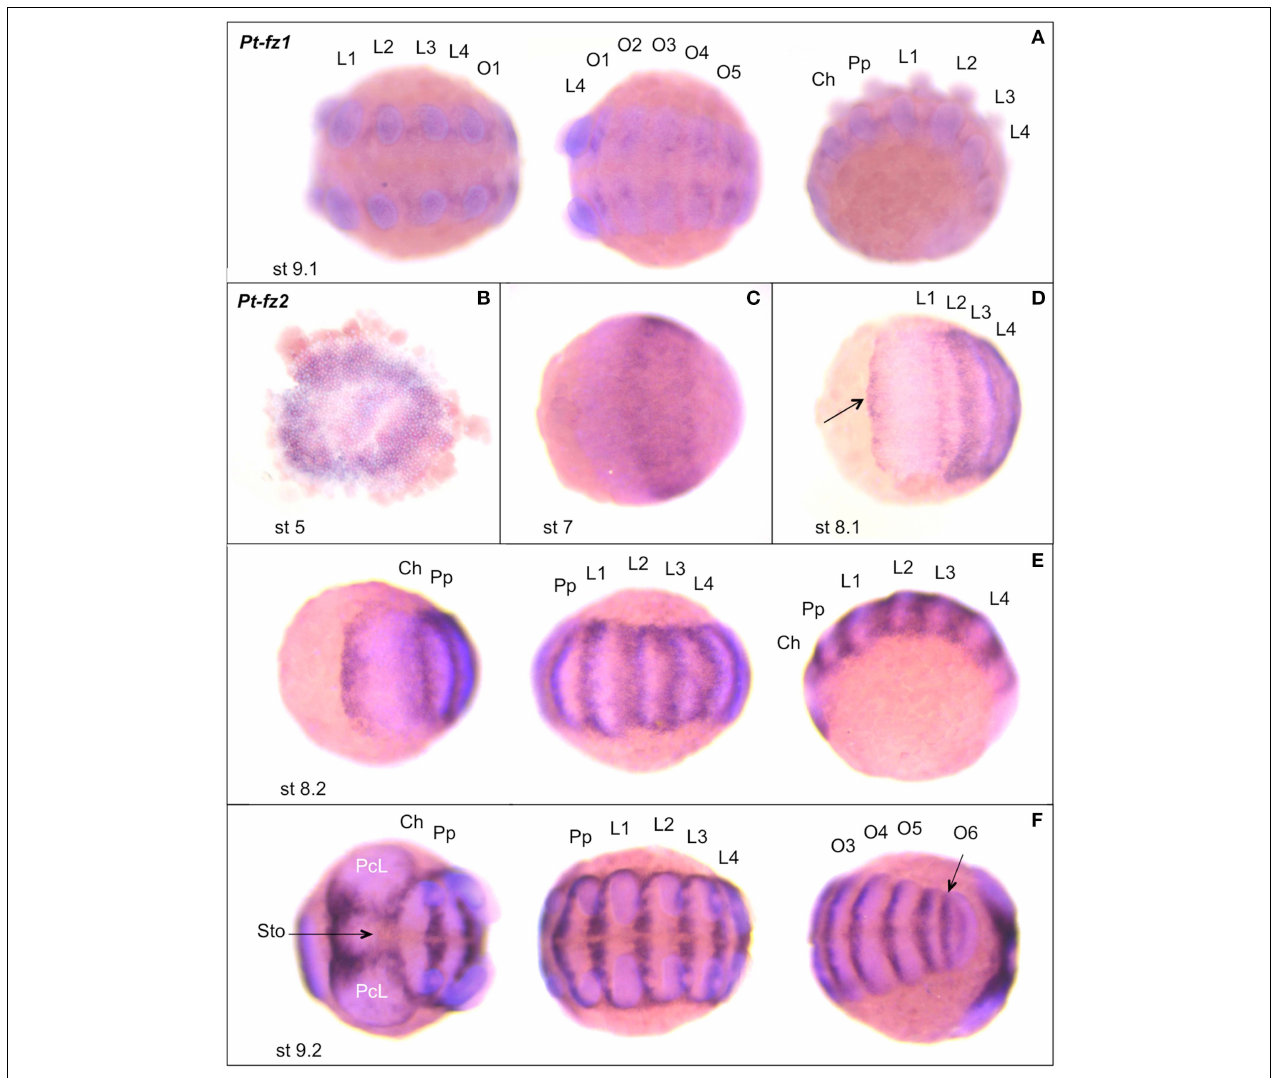
Germ band (anterior prosoma, posterior prosoma, and opisthosoma/SAZ view). The arrow in (D) indicates the expression domain along the anterior border of the germ band. The arrow in (F) marks expression at the stomodaeum. Developmental stages are indicated. L, walking limb; O, opisthosomal segment; Ch, cheliceres; Pp, pedipalps; PcL, precheliceral lobe; Sto, stomodaeum; st,